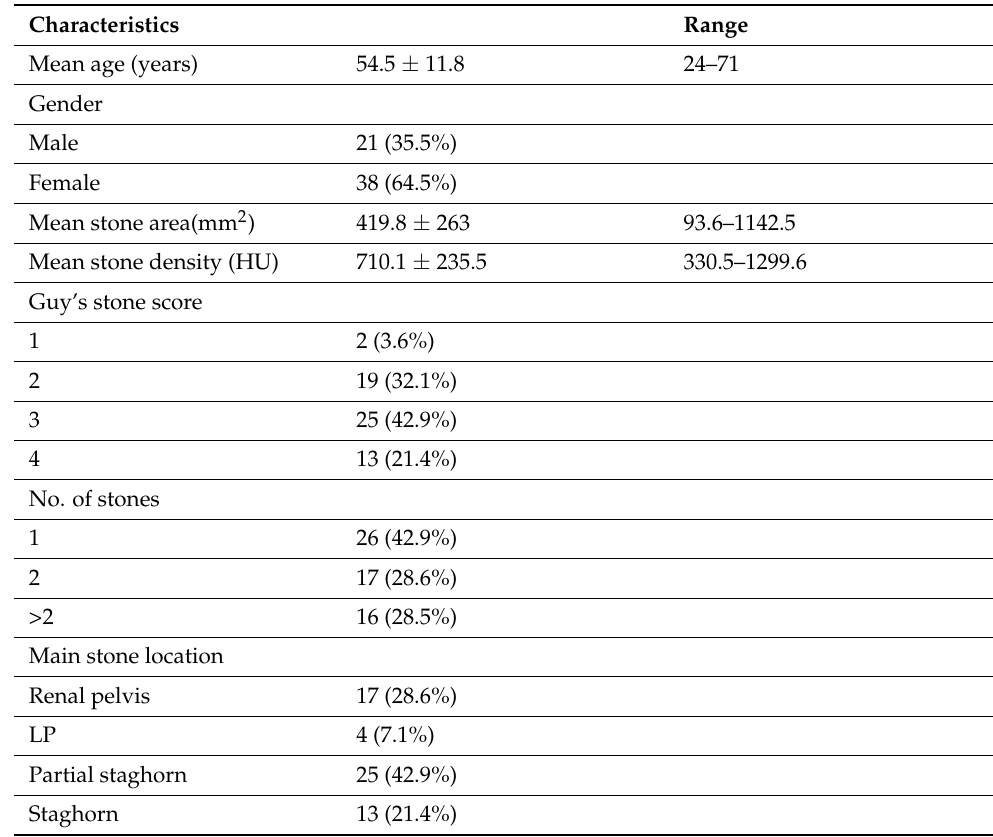
Figure 3. Stone free by Guy’s score in the Trilogy group.